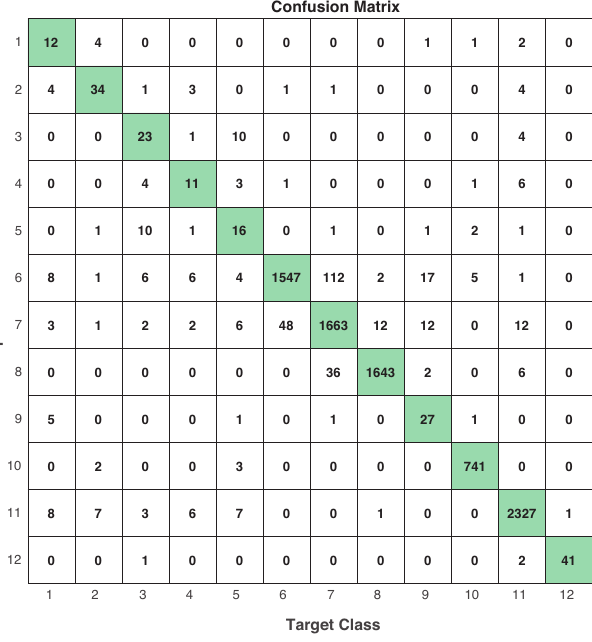
Figure 16. Confusion matrix in testing using MLP with 1-second window size in IMU + EEG + CAM. Numbers in diagonal represent the times a target class is estimated correctly. Performance: